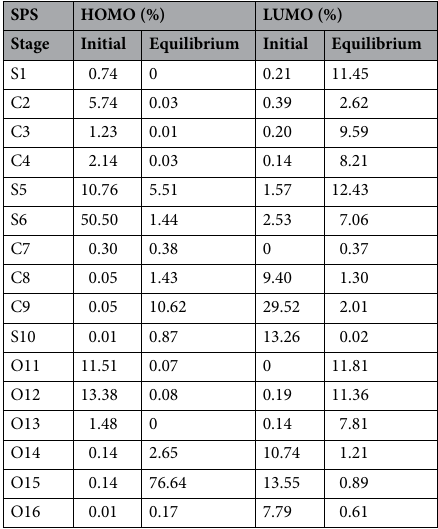
Table 4. Components of SPS molecular orbitals.